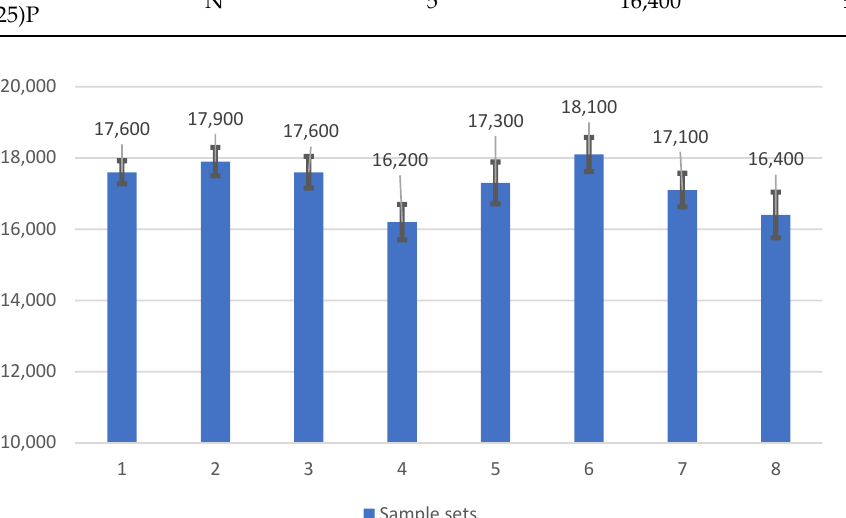
Figure 3. Type II trans-jacket FBG fatigue test results. The sample set numbers in Figure 3 correspond to the sample set numbers and fibre types in Table 4.